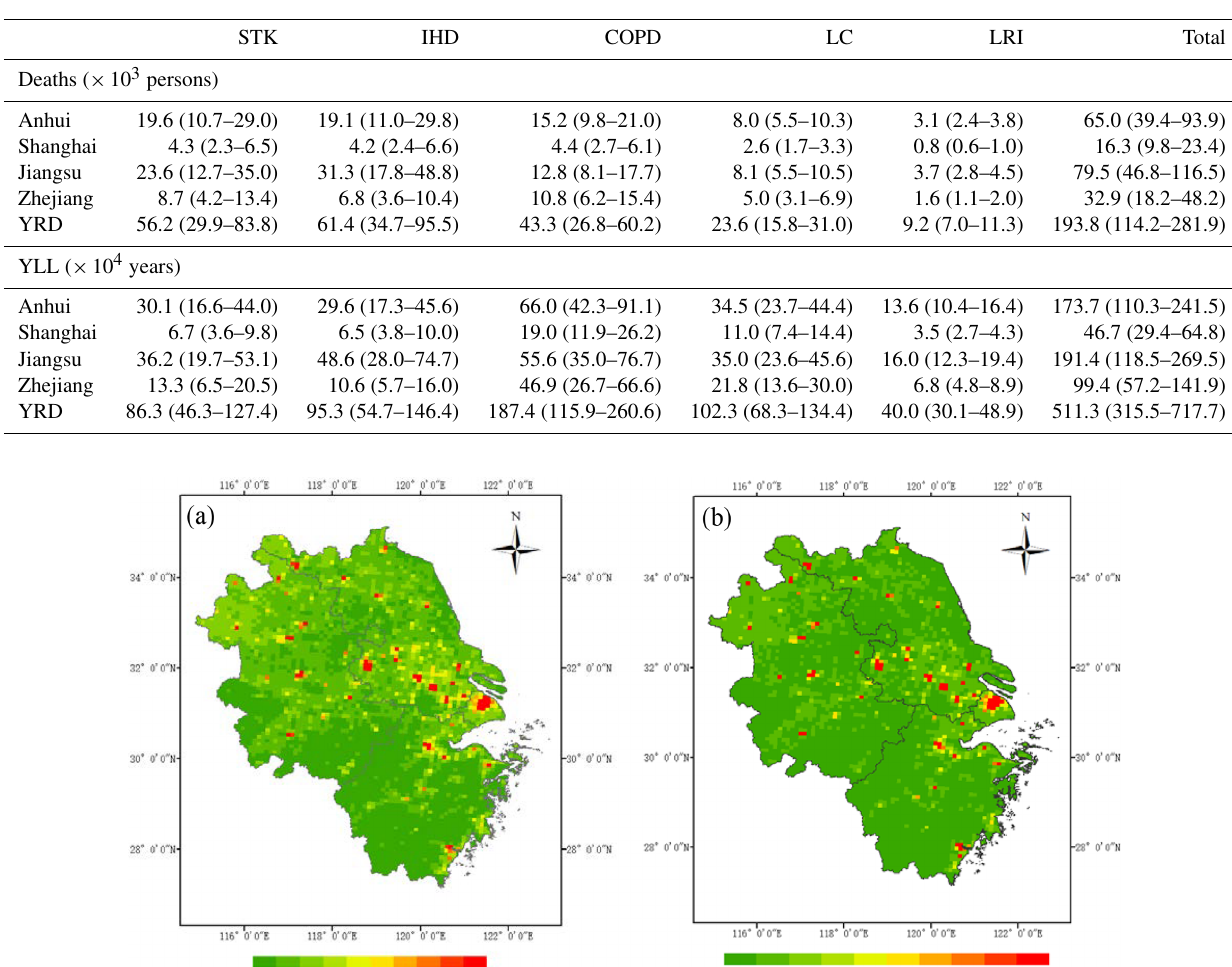
Table 4. The estimated mortality and YLL attributable to PM 2 . 5 exposures in case 2 over the YRD region.